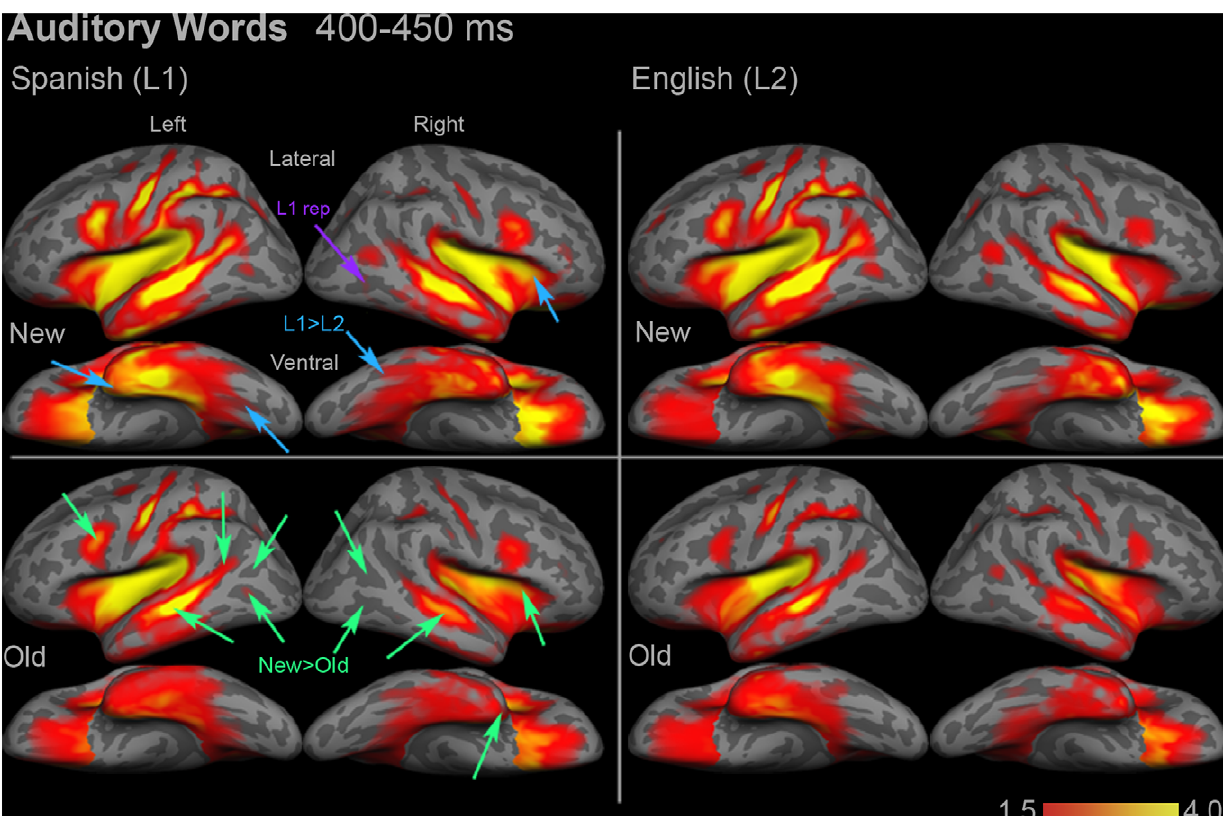
Figure 6. Group dSPM images of the mean activity evoked by auditory words from 400–450 ms. Several regions in both hemispheres showed Spanish . English effects (blue arrows). Note that the activity associated with the N400m in the regions of Wernicke’s and Broca’s areas was not significantly different between Spanish and English. Stimulus repetition effects (green arrows) were significant in many regions. One area, right inferior LOT, showed a new . old N400 effect in Spanish but not in English (purple arrow). See Supplementary Figure S2 for ROI locations and names. Color bars represent square root of F values, which are a measure of signal-to-noise.